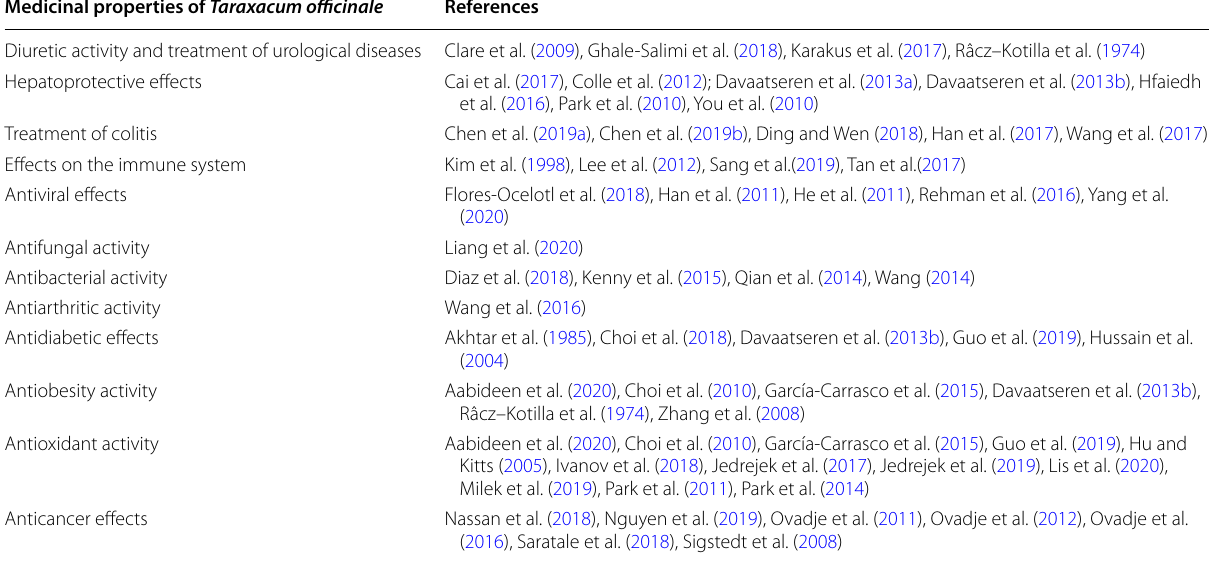
Table 1 Medicinal properties of Taraxacum officinale. The results of literature review are reported in the table Medicinal properties of Taraxacum